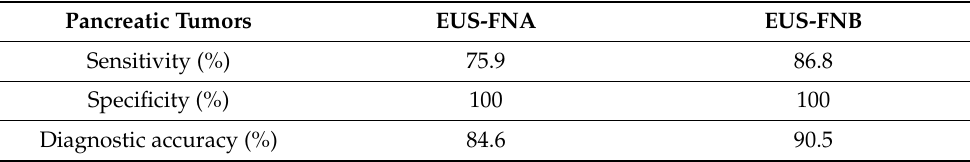
Table 7. Percentage of EUS FNA/FNB needles used.